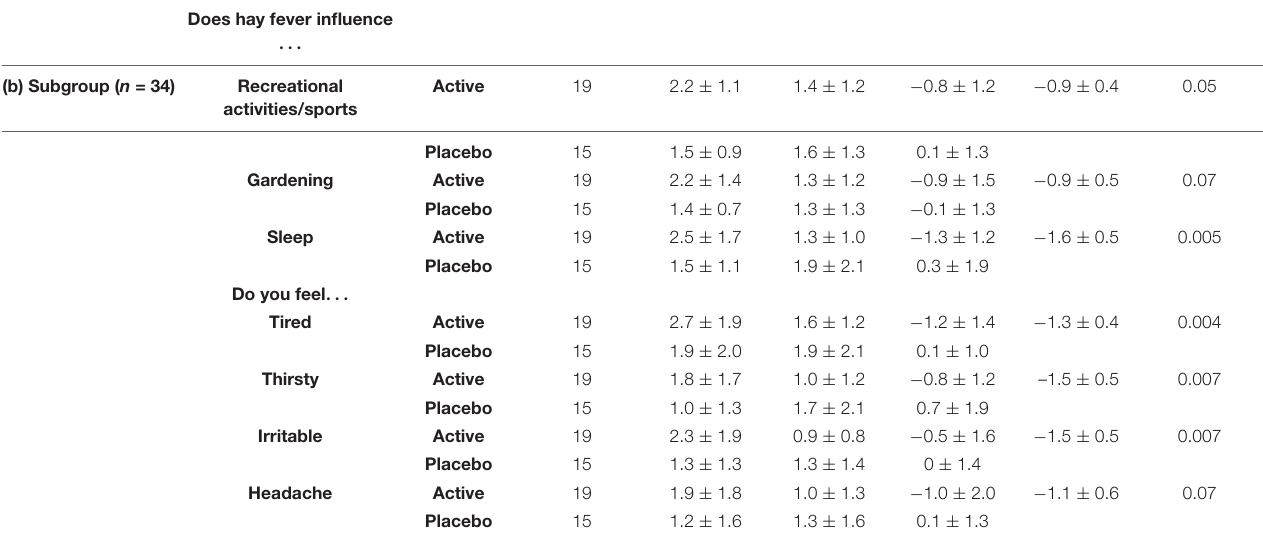
between groups Mean p -value change ± SD diff ± SE